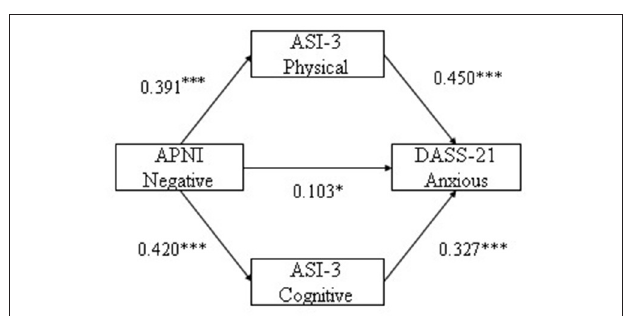
FIGURE 2 | The mediating pathway of physical and cognitive concerns in negative bias influence anxious. * p < 0.05, *** p < 0.001.